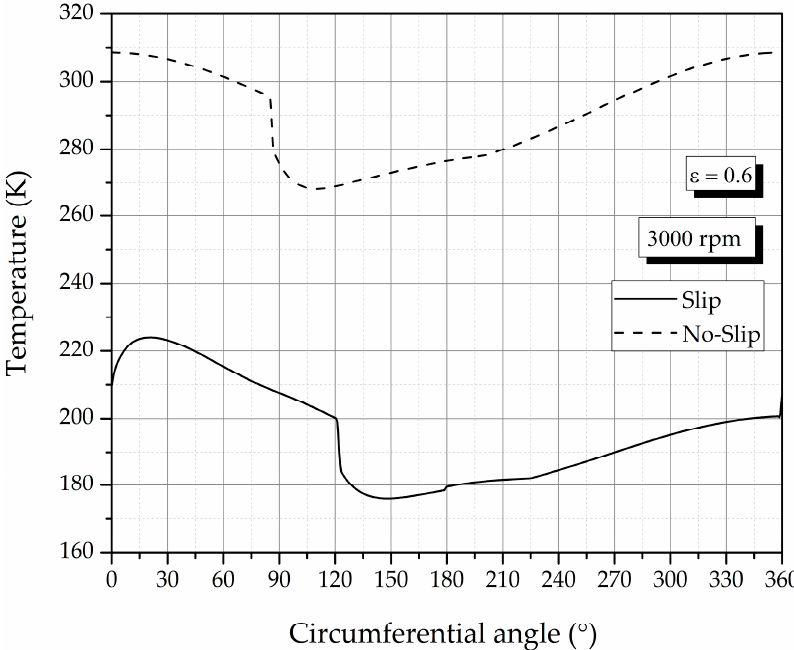
Figure 9. Comparison of the profile of temperature between the conventional (no-slip) bearing and heterogeneous slip/no-slip bearing. All results are evaluated at z / L = 0.5 and n = 3000 rpm.